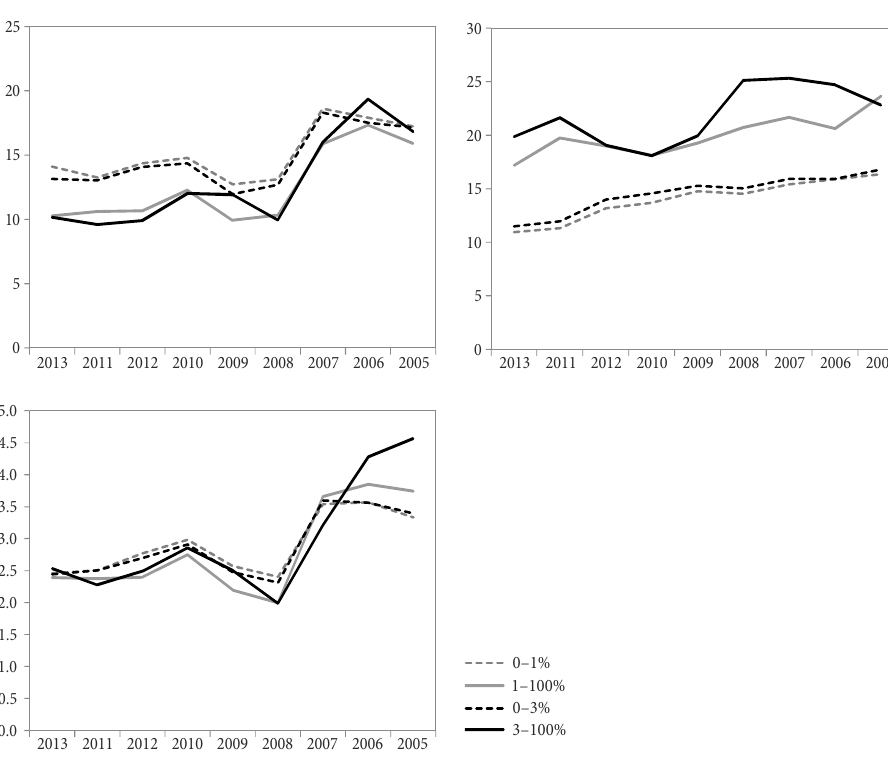
Fig. 3. Median ROE, GM and PM based on the intangibles levels Source: